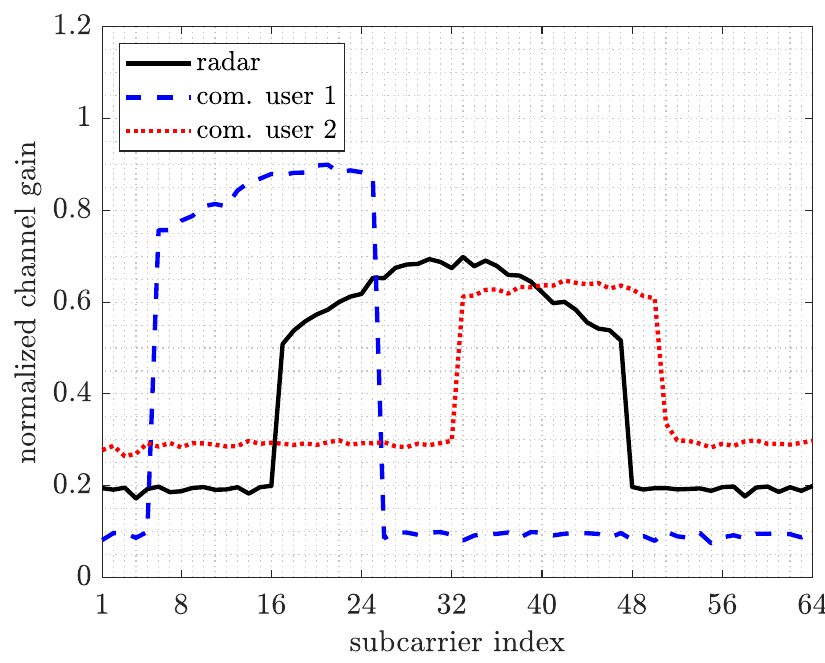
Figure 3. Radar and communication channel conditions for the simulations under